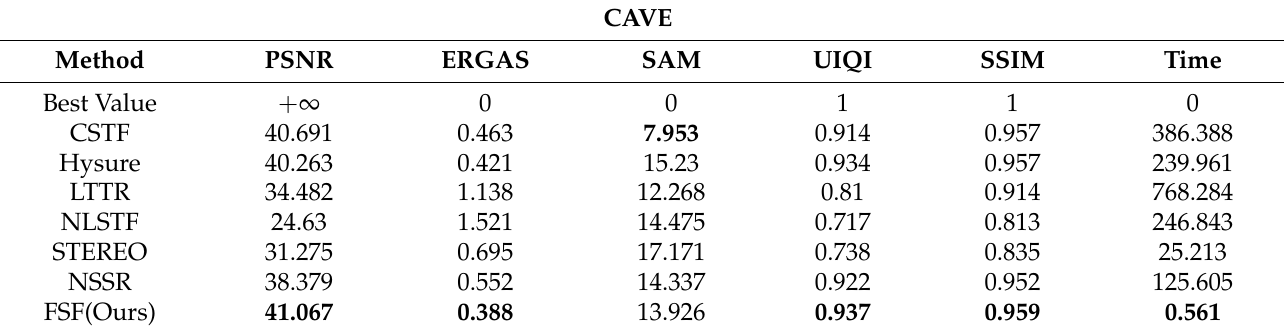
Table 4. The quantitative results of the experiment on the CAVE dataset. The best results are shown in bold among all